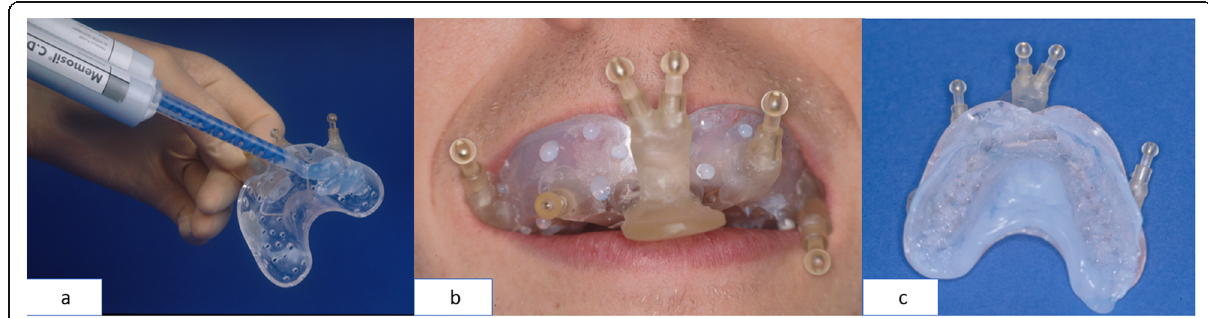
Fig. 4 Production of an oral splint for the maxilla (maxillary splint, MaxS): a ready-made impression spoon armed with fiducial markers filled with a-silicone, ( b ) intraoral view of the MaxS, ( c ) extraoral view of MaxS